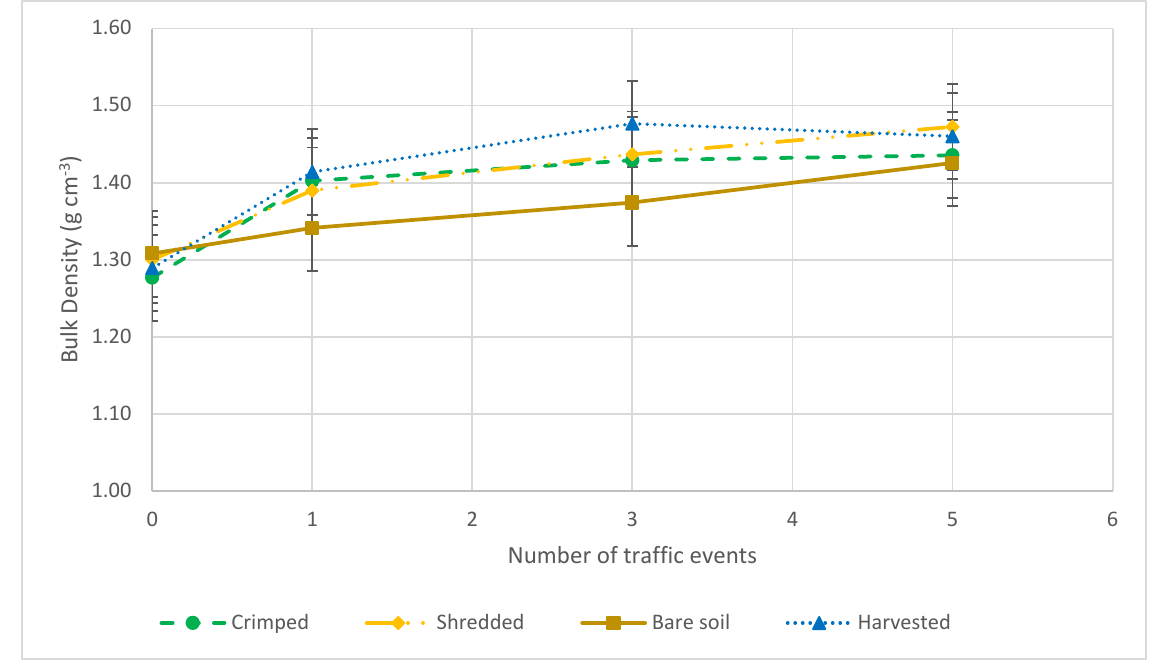
Figure 7. Bulk density means resulted from different number of traffic events and cover crop mulch treatments (Harvested; Bare soil; Crimped; Shredded). Residual standard errors were used on the bar error.